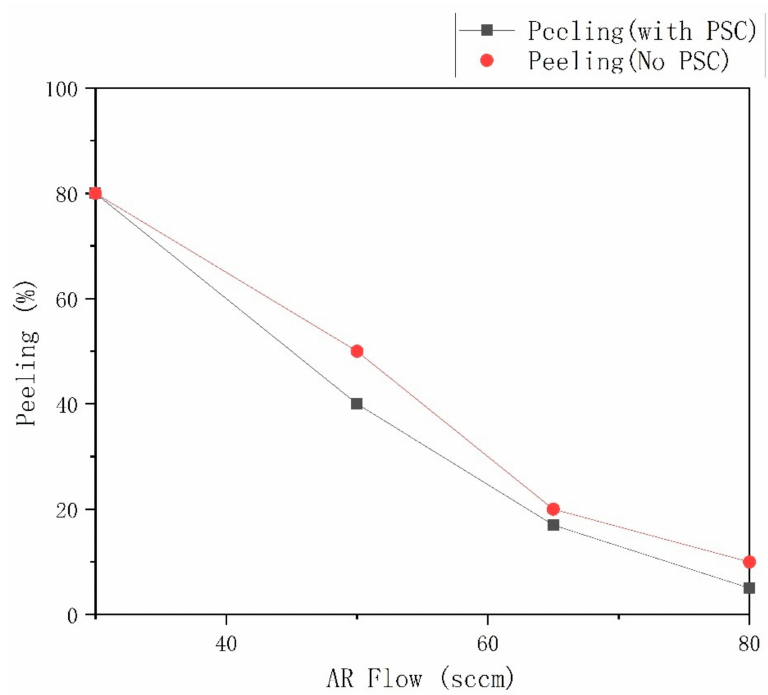
Figure 4. Peeling test results with Different Argon flow for SiO 2